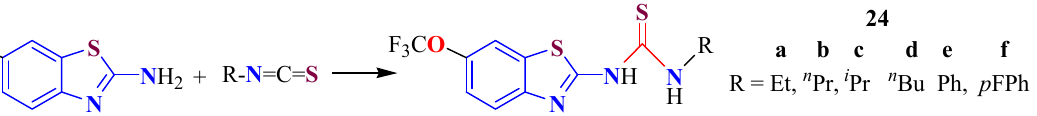
oxygen species (ROS) scavenging activity. Compounds 24a and 24b were also evaluated for their activity on voltage-dependent Na + and K + currents in neurons from rat piriform cortex. At 50 μ M, compound 24b inhibited the transient Na + current to a much smaller 50 µ M, compound 24b inhibited the transient Na + current to a much smaller extent than extent than Riluzole, whereas 24d was almost completely ineffective. extent than Riluzole, whereas 24d was almost completely ineffective. Riluzole, whereas 24d was almost completely ineffective.